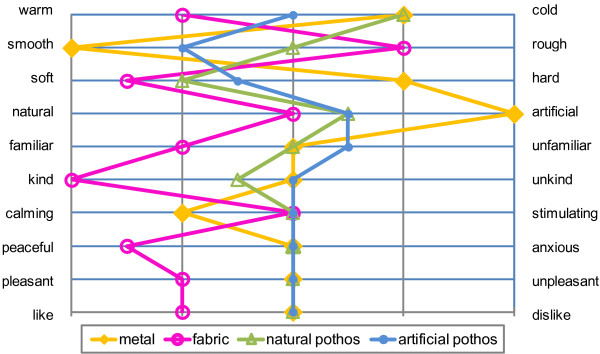
Result of the evaluation profile of the subjects’ impressions using the SD method. These plots show median SD score.